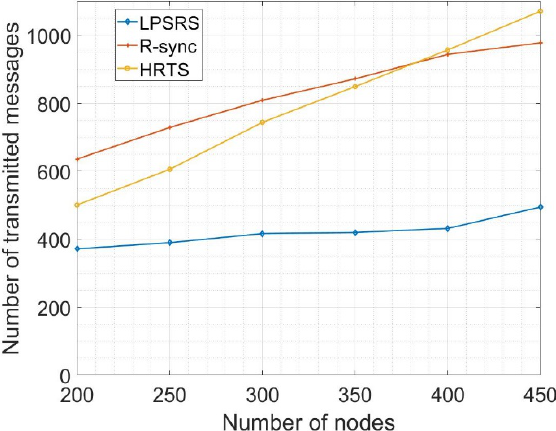
= 85 m, N = 240: 450). Figure 7. Required number of messages ( r = 85 m, N = 240: 𝑟𝑟